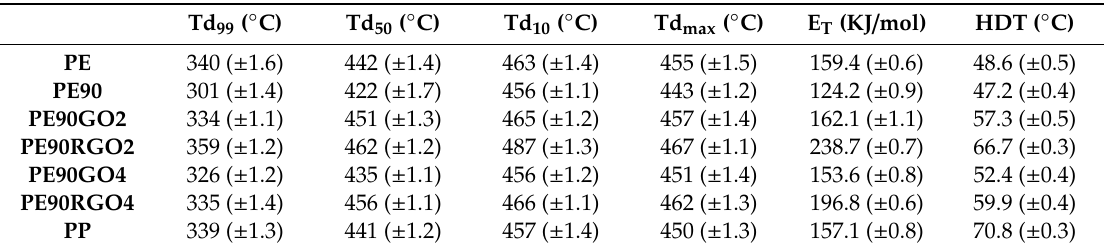
Table 2. Thermal properties of unfilled and filled binary systems. HDT: Heat Deformation Temperature.